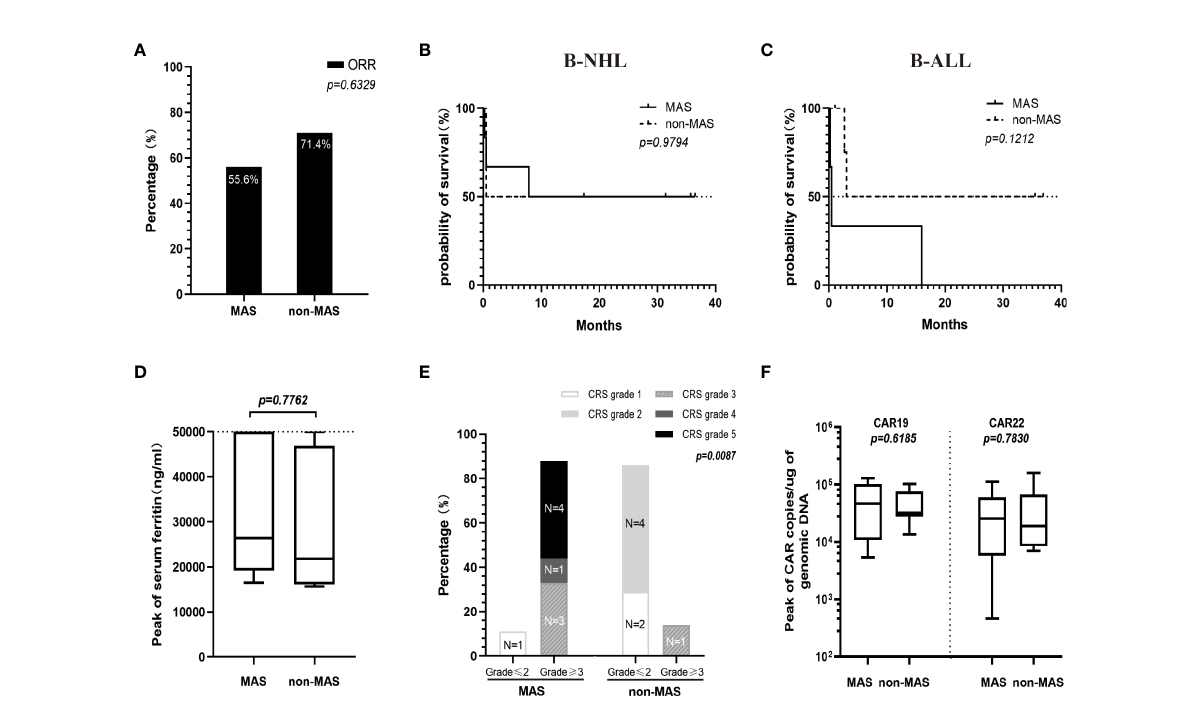
FIGURE 3 Comparison between patients of the HFA group with MAS (n=9) and without MAS (n=7) in ORR (A) , OS (B, C) , levels of serum ferritin (D) , CRS grade (E) and the peaks of CAR transgene copies (F) . (D) The medians of the peak values of serum ferritin in patients with or without MAS were 26328 (range, 16479-50000) ng/ml and 21750 (range, 15650-50000) ng/ml, respectively. (E) Patients with MAS had a signi fi cantly higher high- grade CRS ( ≥ 3) rate than patients without MAS (P=0.0087). (F) The peak values for CAR19 and CAR22 transgene copies in the MAS group (median 46393, range 5441-129375 copies/µg for CAR19 and median 25688, range 464-112033 copies/µg for CAR22) were not signi fi cantly different from those in the non-MAS group (median 31909, range 13473-102707 copies/µg for CAR19 and median 18924, range 6970-159171 copies/µg for